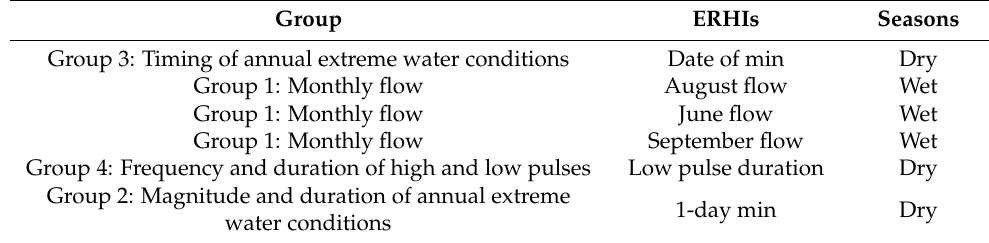
Table 5. Coverage analysis of indicators.